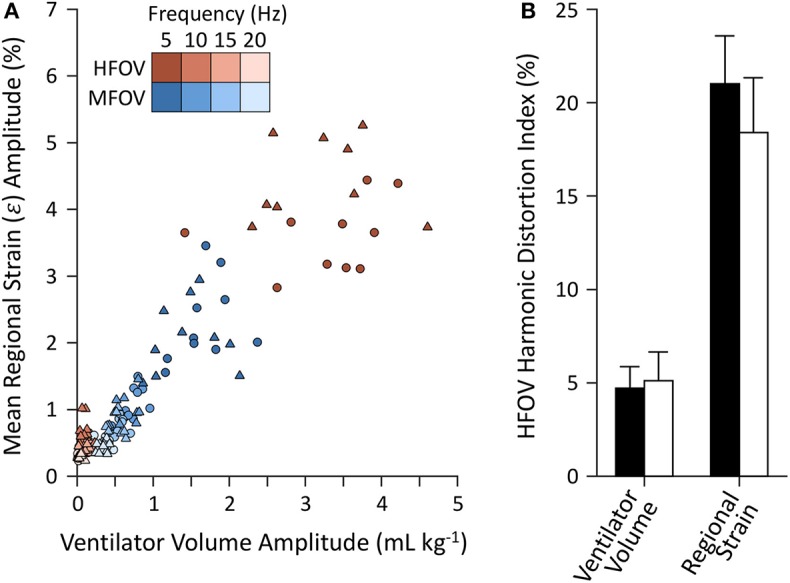
Harmonic amplitudes (A) from imaging-based regional strain measurements and corresponding amplitudes from the ventilator volume waveform measured at the airway opening under baseline (circles) and injured (triangles) conditions. Harmonic distortion index (B) mean and standard deviation for each set of measurements, grouped by baseline (black) and injured (white) lung conditions.